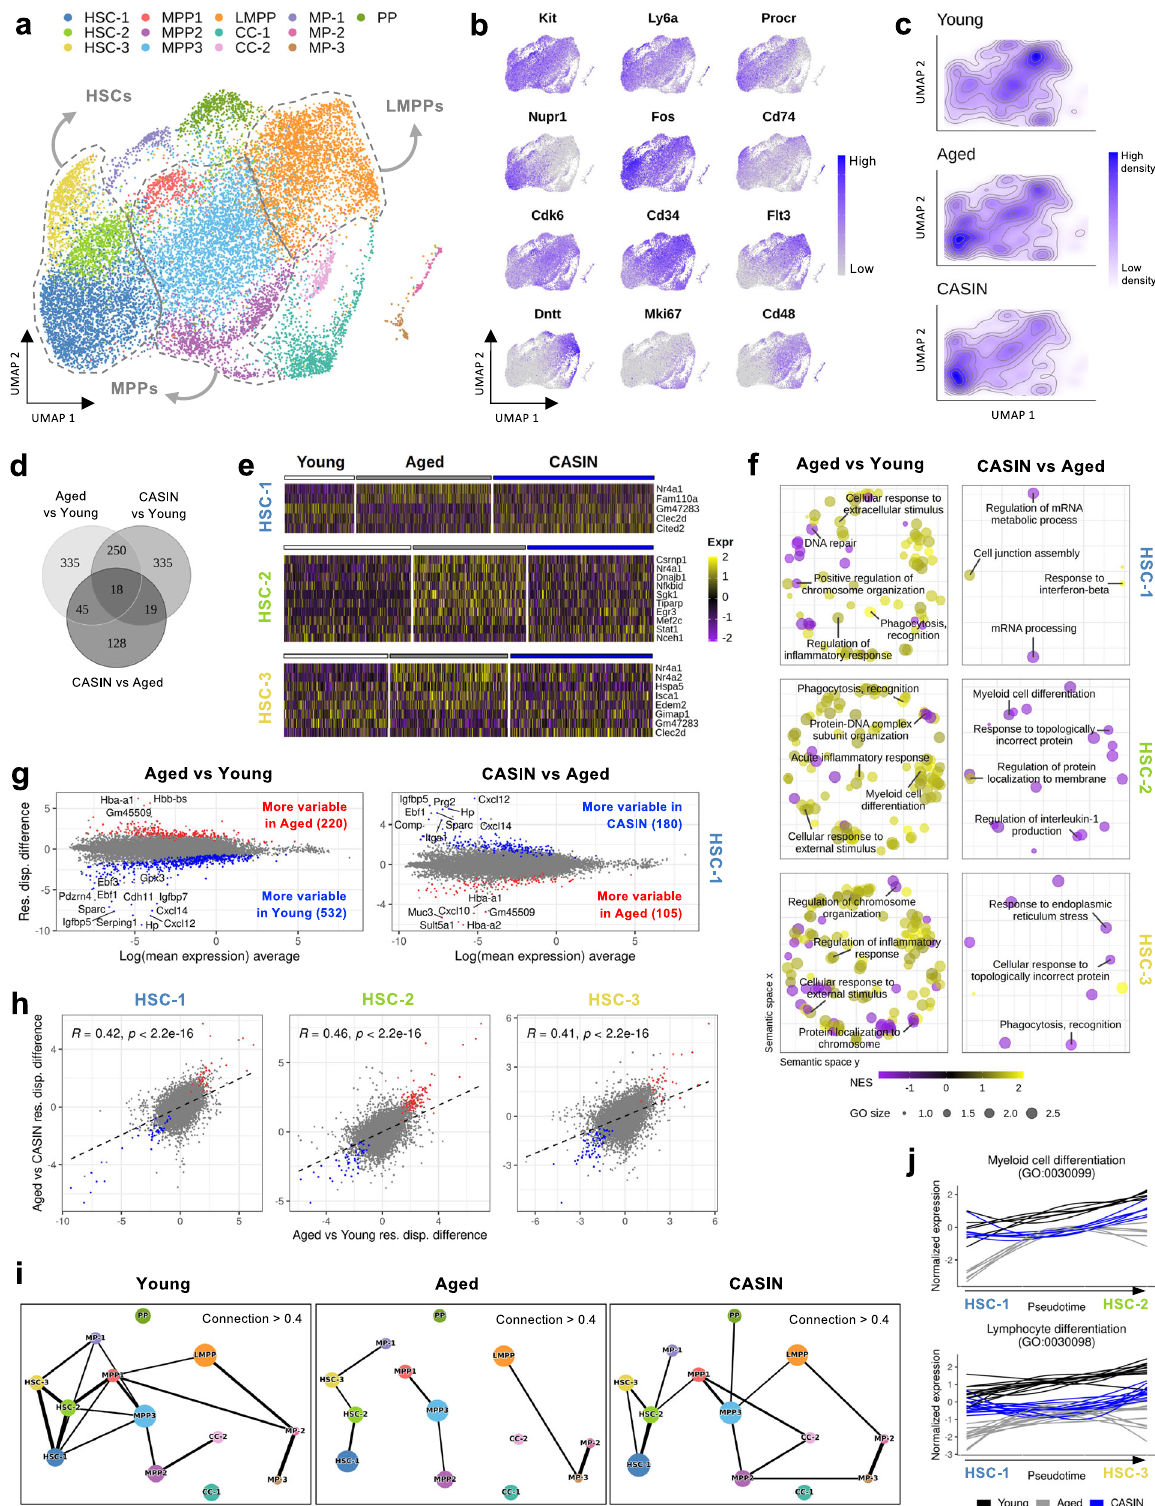
(96.2%, 94.4%, and 96.3% for HSC-1, HSC-2, and HSC-3, respectively; Supplementary Fig. 8b) CASIN reverted the effects of aging on transcriptional variability. To further con fi rm this, we calculated the correlation between the residual dispersion differences in aged over young and in aged over CASIN,